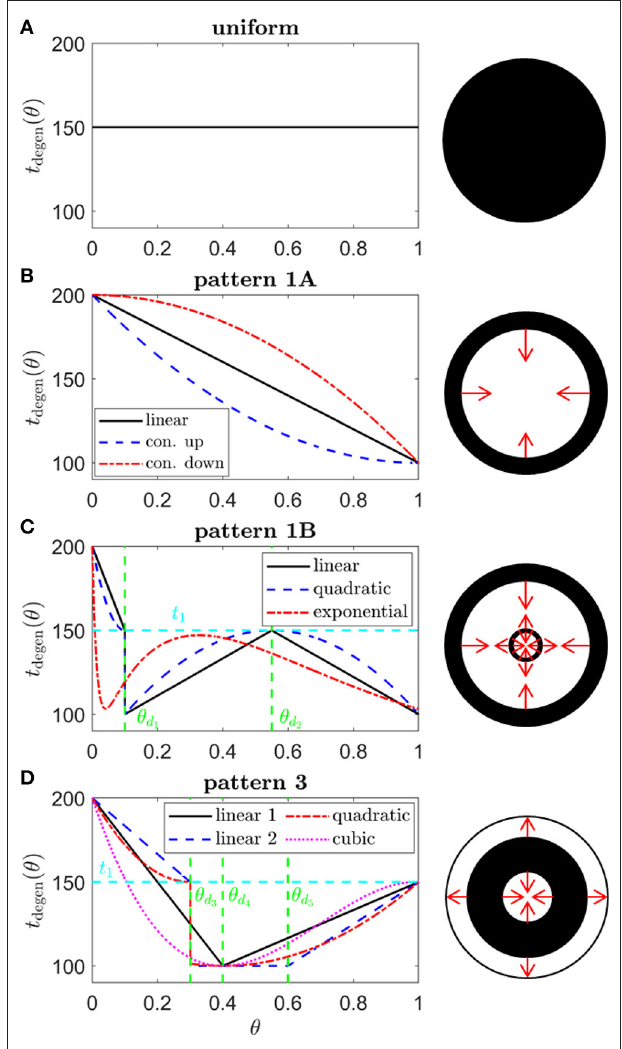
FIGURE 5 | Target cone degeneration profiles. Panels (left) show cone degeneration profiles, t degen ( θ ), qualitatively replicating typical spatio-temporal patterns of visual field loss in RP: (A) Uniform, (B) Pattern 1A, (C) Pattern 1B and (D) Pattern 3. Visual field loss patterns directly correspond to cone degeneration patterns in these radially symmetric cases. We seek to replicate ( θ ) profiles in these patterns by finding appropriate φ r ( θ ) and f crit inv inv Figures 6 – 9 . Diagrams on the right show the corresponding 2D patterns of visual field loss — white regions: preserved vision, black regions: scotomas (blind spots), and red arrows: direction of scotoma propagation. Parameters: t 0 = 100 ( ∼ 11.0 years), t 1 = 150 ( ∼ 16.6 years), t 2 = 200 ∼ 22.1 years, θ d = 0.1 ( ∼ 7.6 degrees), θ d = 0.55 ( ∼ 41.9 degrees), θ d = 0.3 ( ∼ 22.9 1 2 3 = 0.4 ( ∼ 30.5 degrees) and θ d = 0.6 ( ∼ 45.7 degrees). Cone degrees), θ d 4 5 degeneration profile formulas and parameters are given in Table 3 . Remaining parameter values as in Table 2